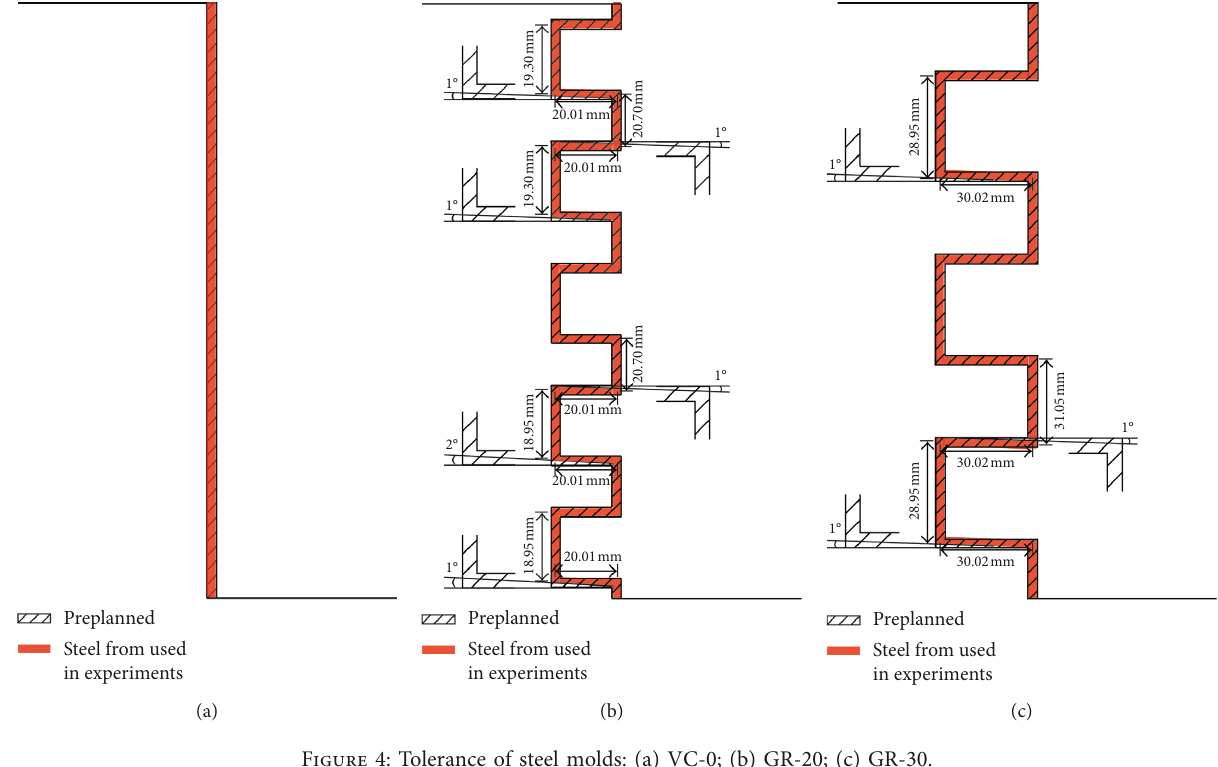
Figure 4: Tolerance of steel molds: (a) VC-0; (b) GR-20; (c)